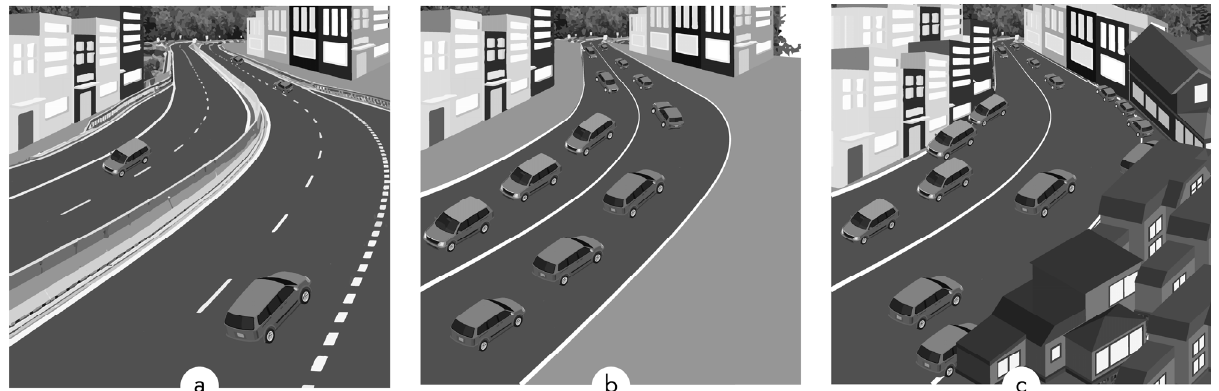
Figure 1. A schematic design of ( a ) physical, ( b ) dynamic, and ( c ) psychological barriers.